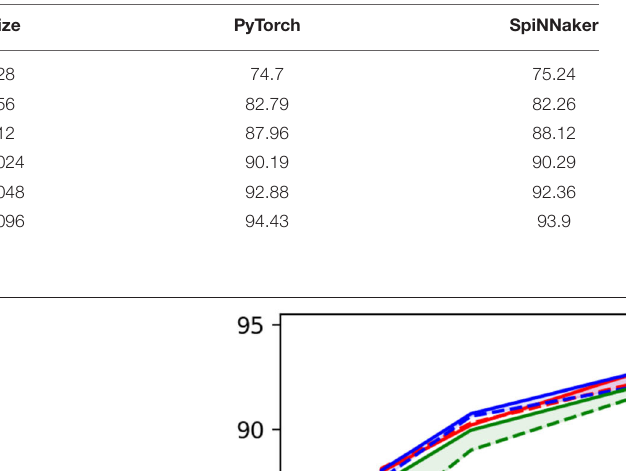
TABLE 2 | Results for different sizes of the hidden layer.